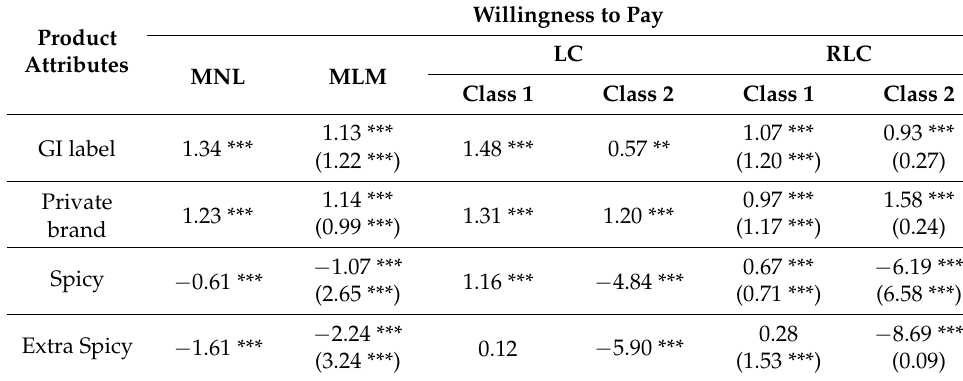
Table 6. Willingness To Pay estimates for the